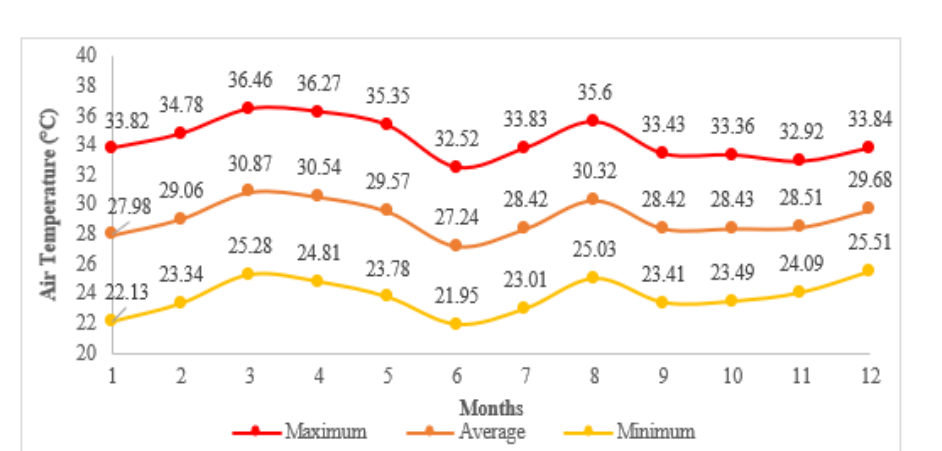
Figure 6. Resulting air temperature of the microclimate data from ENVI-met simulations [8].